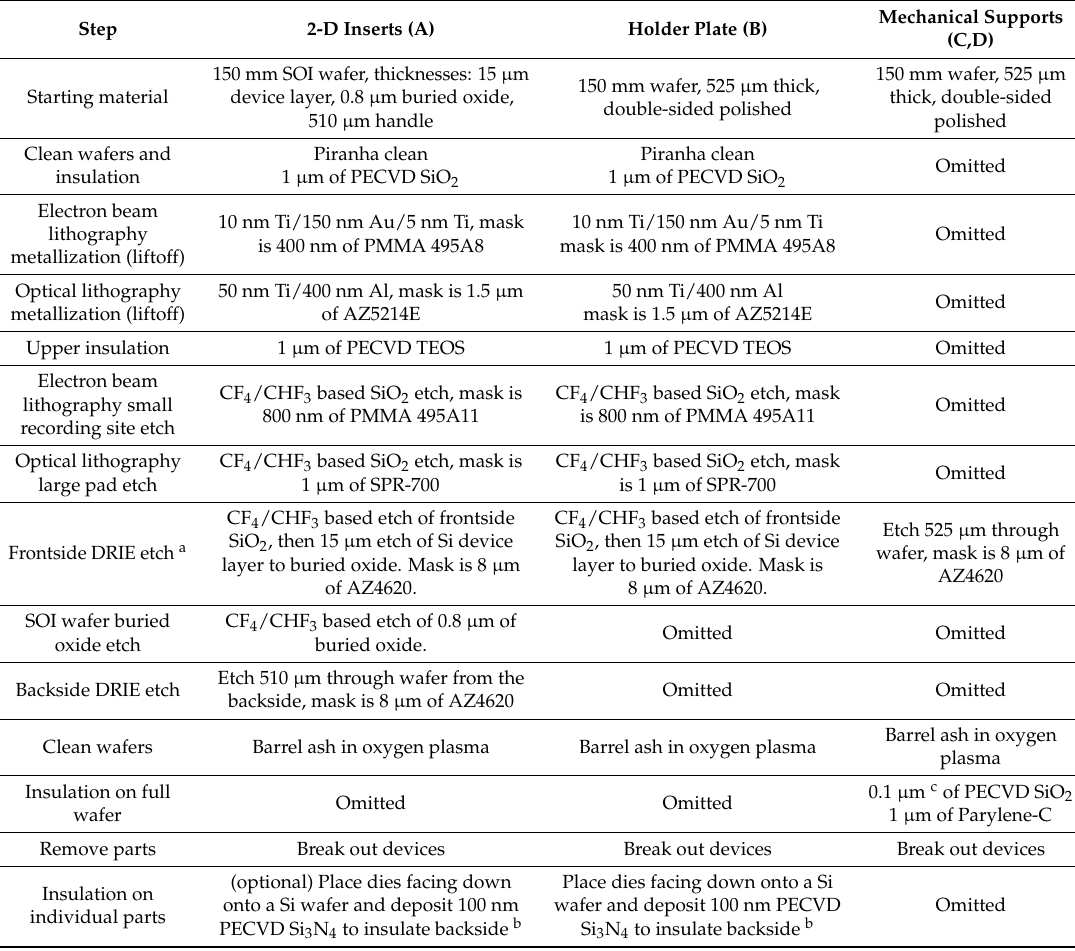
Table 2. Overview of Processing Steps. Summary of the process steps to fabricate the components of Figure 3. The process is adopted from and uses the same tools as our 2-D probes in